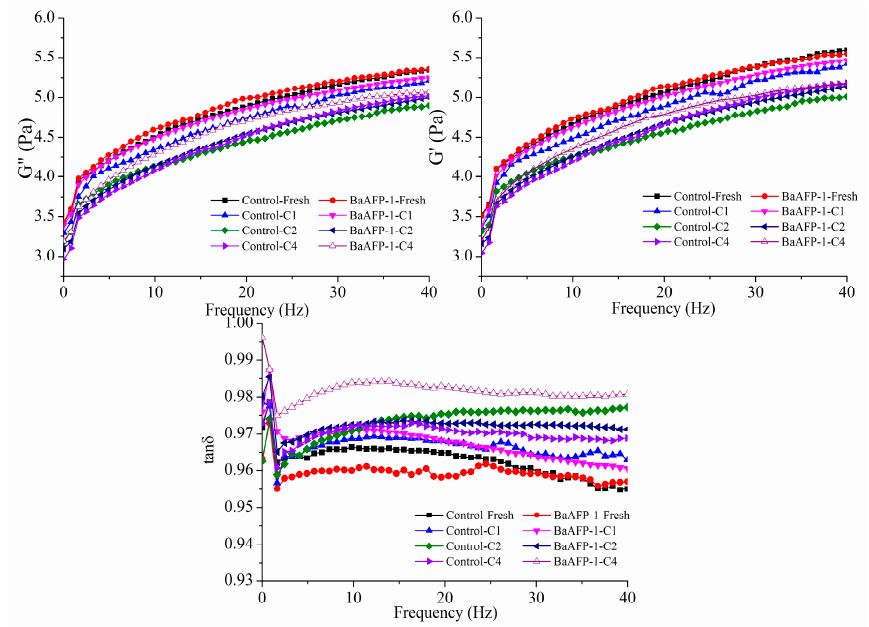
Figure 1. E ff ect of BaAFP-1 on the dynamic rheological of dough Figure 1. Effect of BaAFP-1 on the dynamic rheological of dough samples.